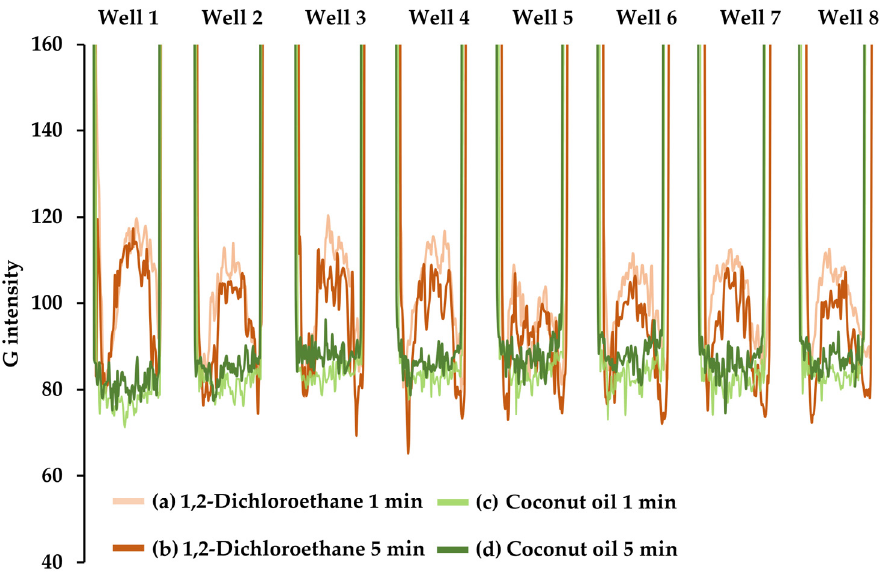
Figure 2. The intensity signal (G intensity) profiles of organic extract (from aqueous Cu(II)-DPC) using DCE at 1 min (a) and at 5 min (b) and coconut oil at 1 min (c) and at 5 min (d). Further study was made for standing time after the extraction. Under the above same color intensity value of the organic (coconut oil) phase was obtained after 1 min.